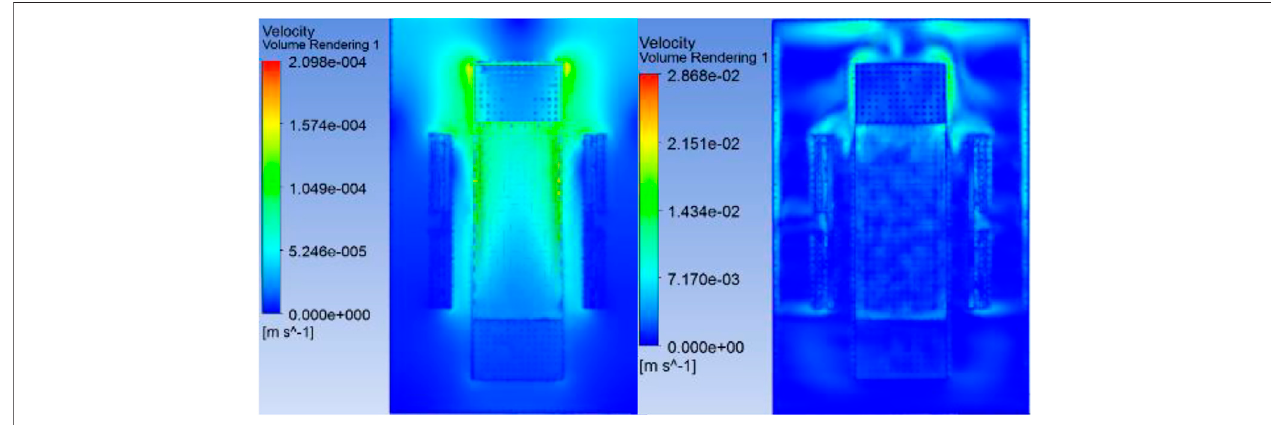
FIGURE 9 | Comparison of heat transfer oil disturbance and natural convection oil fl ow rate.